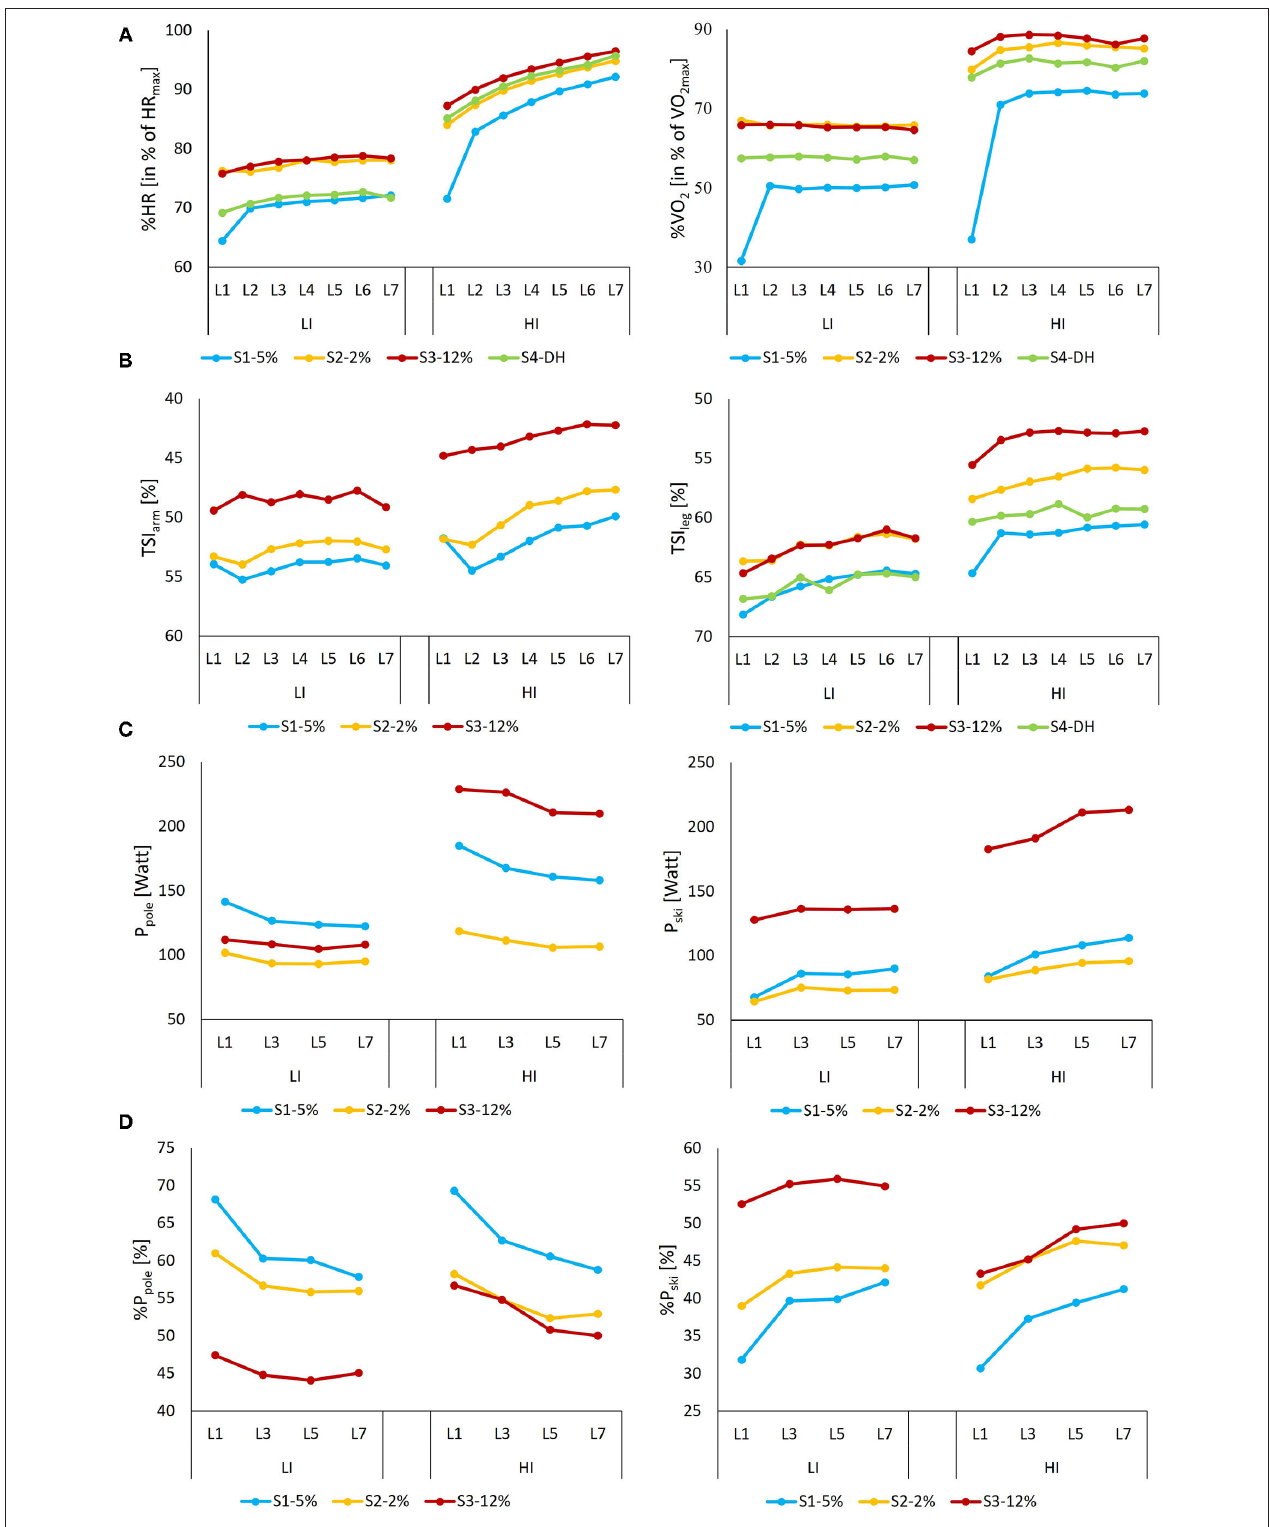
FIGURE 3 | (A) %HR and % ˙ VO 2 , (B) TSI arm and TSI leg , (C) absolute and (D) relative power for pooling (P pole and ski push-offs (P ski for each segment (S1–S4) as a function of the lap (i.e., L1–L7) during LI and HI sessions. For TSI, the vertical axis is reversed, and TSI arm in the simulated downhill segment (i.e., S4) is not shown due to excessive movement noise in the signal when the skiers grabbed the